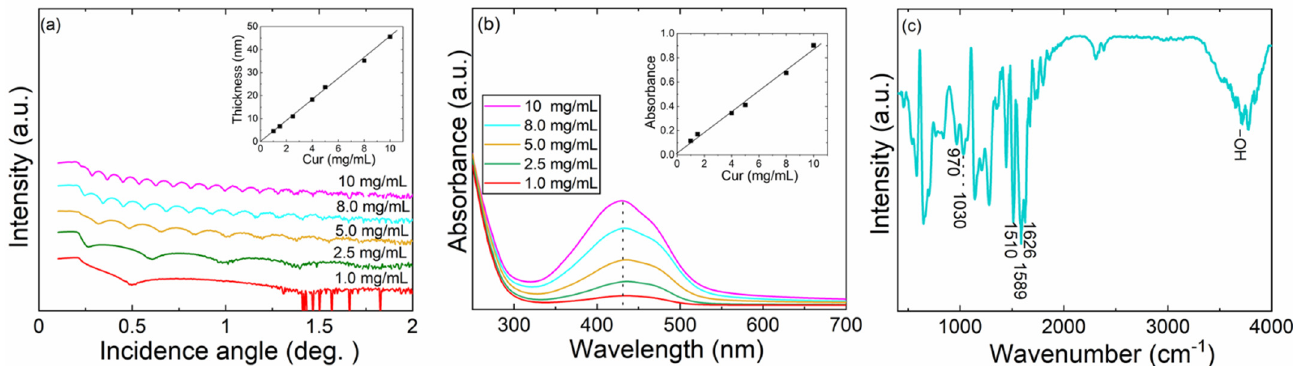
Figure 2. Characterization data for representative S-C-grown Cur films from Cur/ethanol solutions of different concentrations: ( a ) XRR patterns (inset: fitted film thickness versus Cur concentration); ( b ) UV-vis absorption spectra (inset: absorbance versus Cur concentration); ( c ) FTIR spectrum for the film grown from the 8 mg/mL solution.